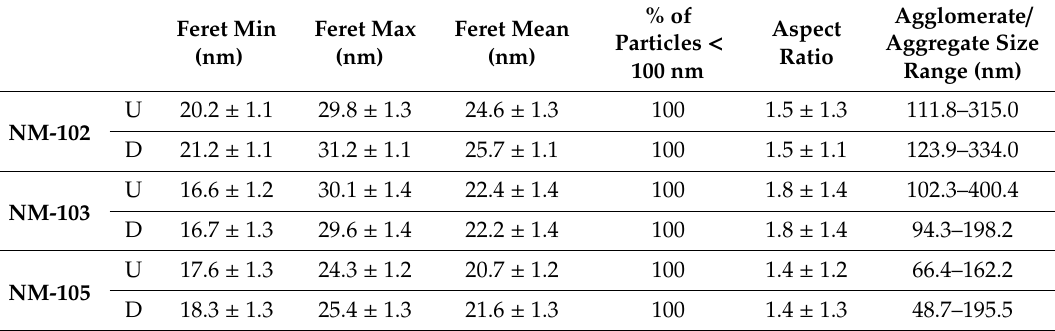
Figure 3. Representative elemental analysis spectra by TEM-EDS. Note: Ti corresponds to titanium and Cu identifies the copper element present in TEM grid. Table 3. Quantitative analysis of size and aspect ratio of the primary particles (geometric mean ± geometric standard deviation) and size range of the agglomerates / aggregates in the